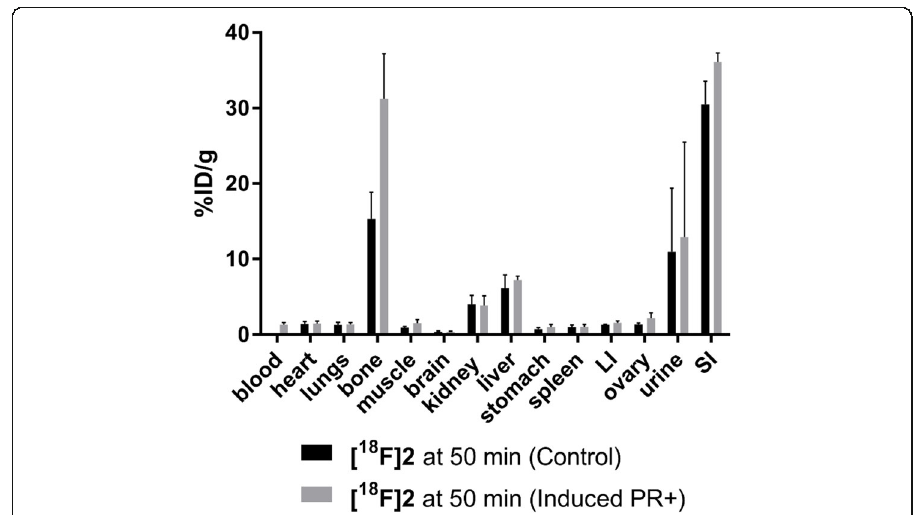
Fig. 4 Biodistribution analysis of selected tissues from C57BL/6 female mice injected with [ 18 F]2 and sacrificed at 50 min post-injection. A group of four animals received a dose of gonadotropins (15 IU FSH + 15 IU LH) plus 5 IU hCG, 48 and 6 h, respectively, before the imaging studies. All radioactivity values were converted in %ID/g of tissue. Biodistribution data are means of ± SEM of three to four animals. LI = large intestine, SI = small intestine. Tabulated values shown in Additional file 1: Table S2